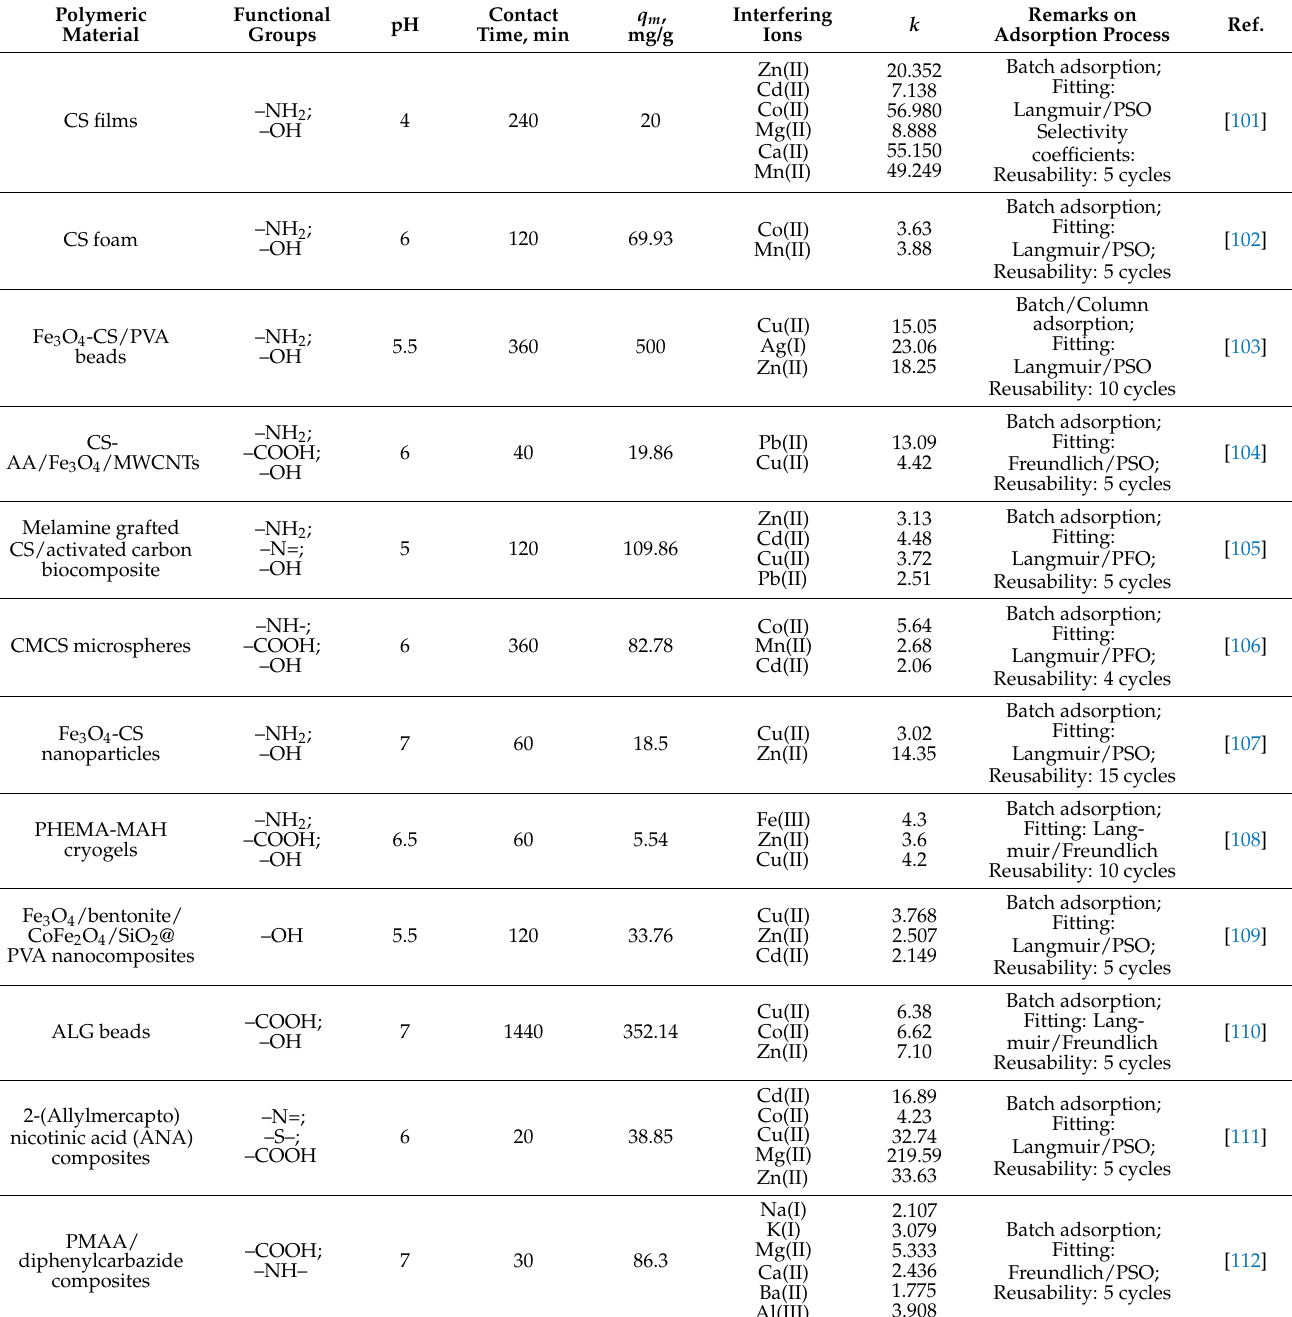
Table 4. Selective extraction of Ni(II) ions by